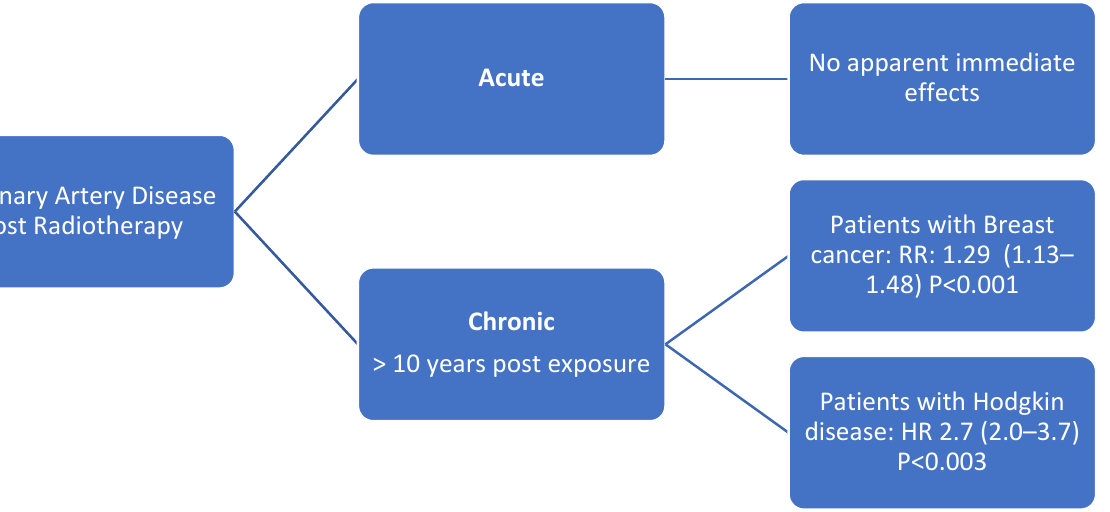
Figure 3. Radiation therapy and coronary artery disease